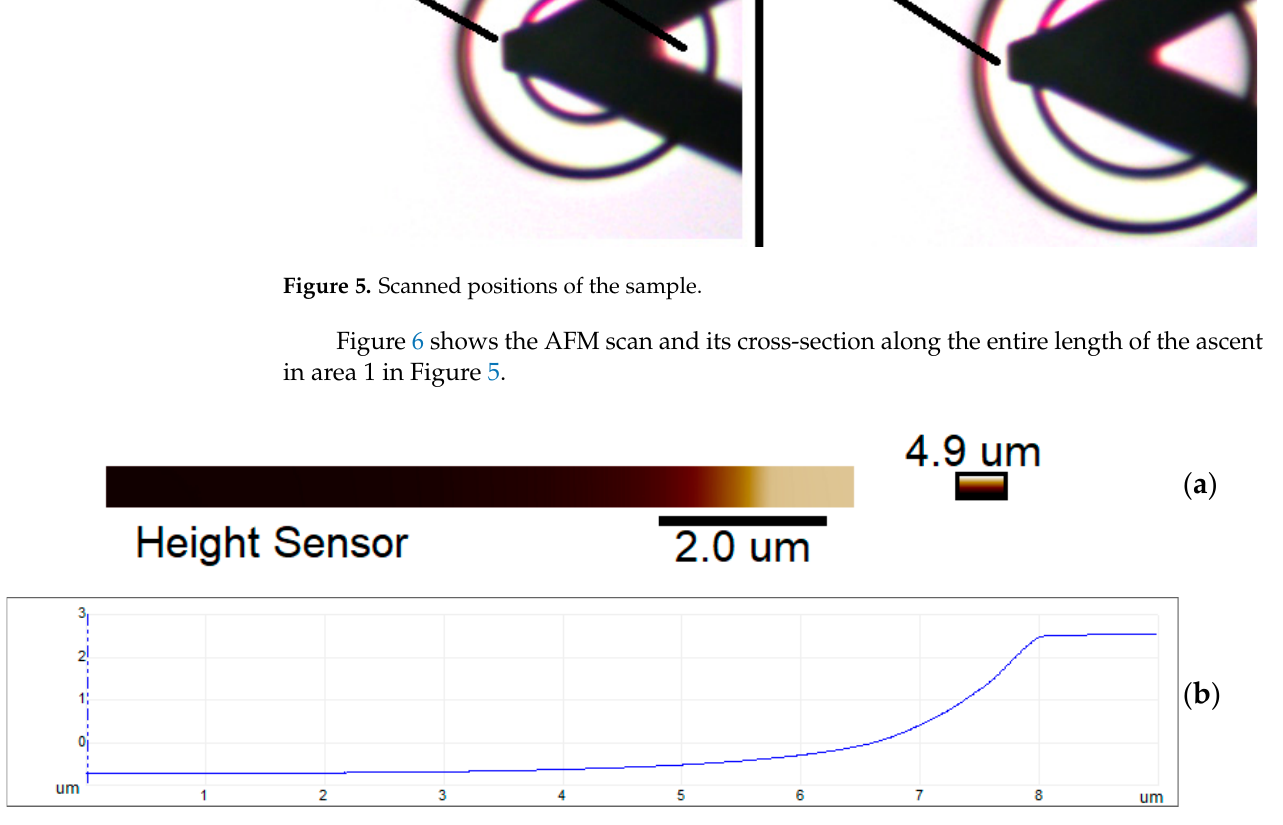
Figure 6. AFM scanning results of the surface profile of the silicon resonator: ( a ) scan of area 1 (resolution: 1024 pixels per line); ( b ) profile of area 1 plotted along the entire length of the ascent.